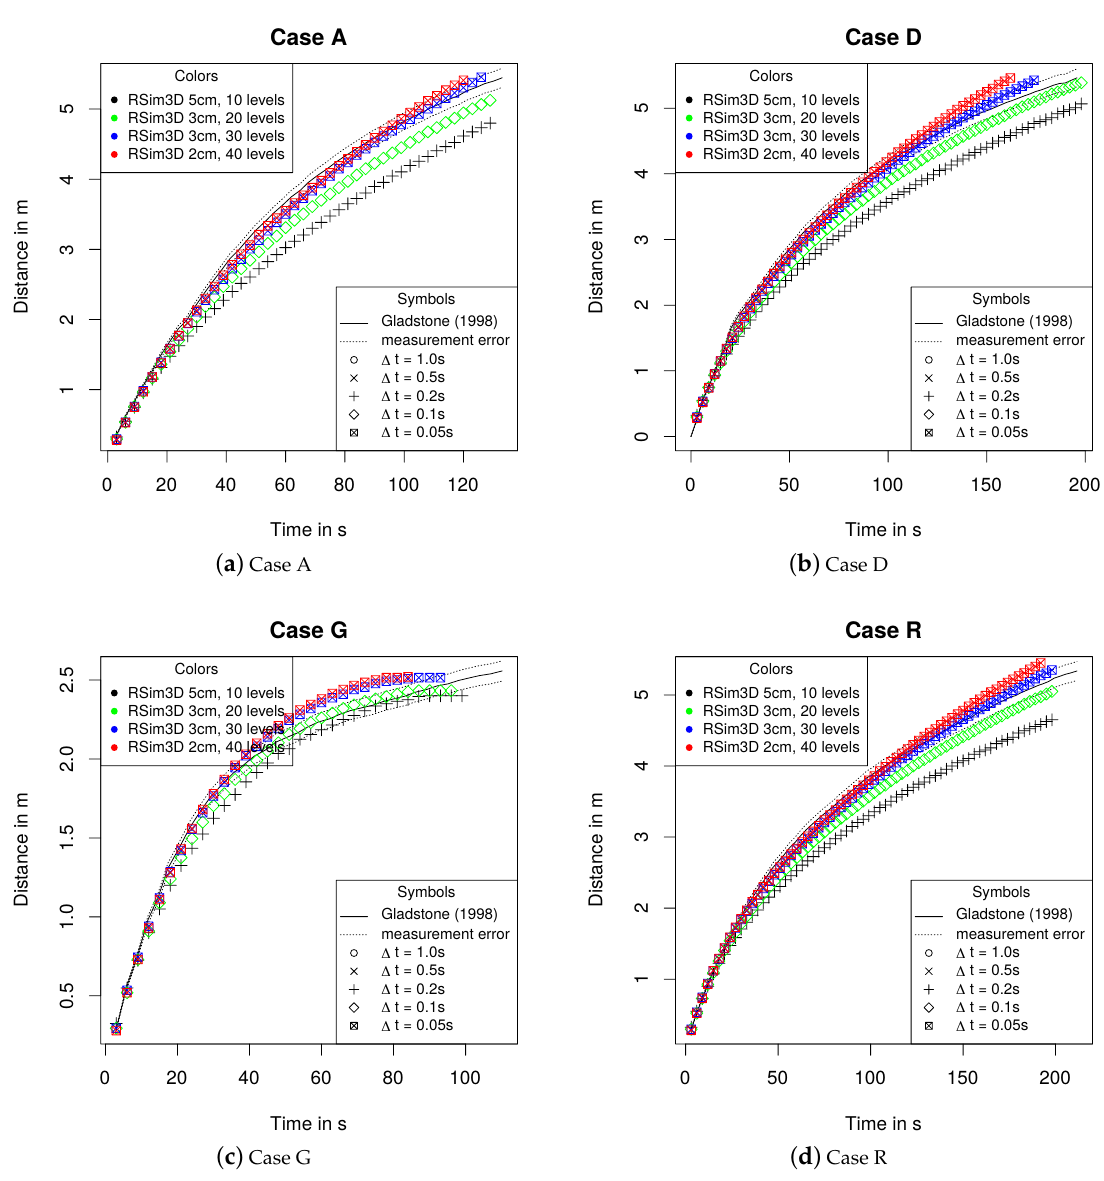
Figure 4. Flow front advance; the time steps correspond to a Courant number of approximately 0.5: ( a ) Case A d = 25µm. ( b ) Case D d 1 = 25µm, d 2 = 69µm. ( c ) Case G d = 69µm. ( d ) Case R d 1 = 17µm, d 2 = 37µm, d 3 = 63µm, d 4 = 88µm, d 5 = 105µm. In cases including more than one grain size the total sediment concentration is uniformly distributed across all